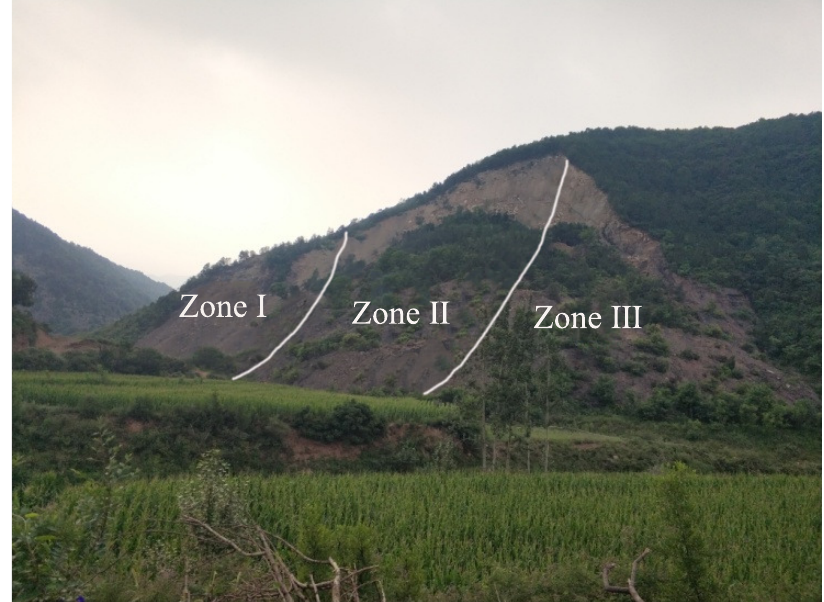
Figure 13. Actual landslide